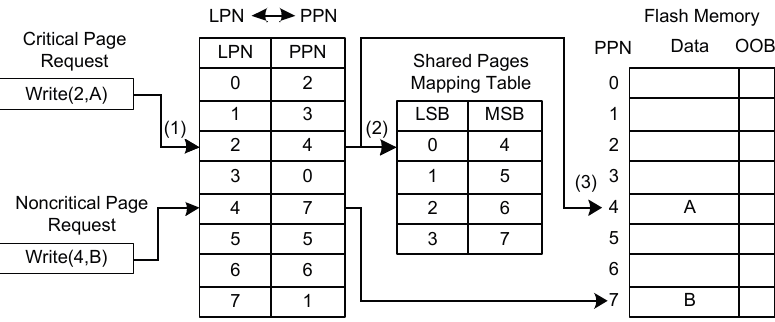
Figure 6. An example of the MSB allocation strategy of Asymmetric Programming.